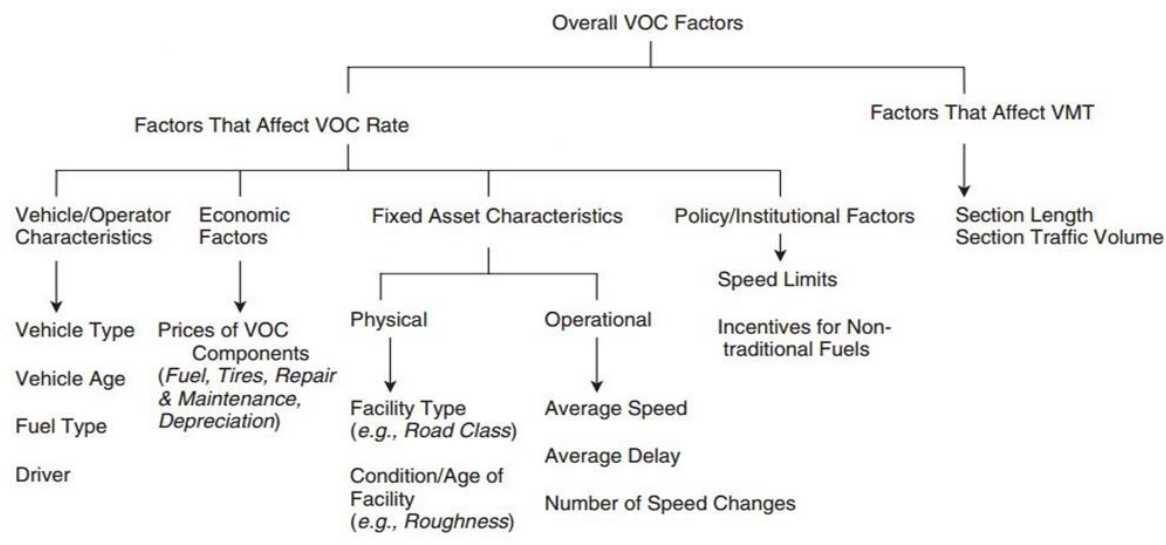
Figure 5: Factors Affecting Highway Vehicle Operating Cost